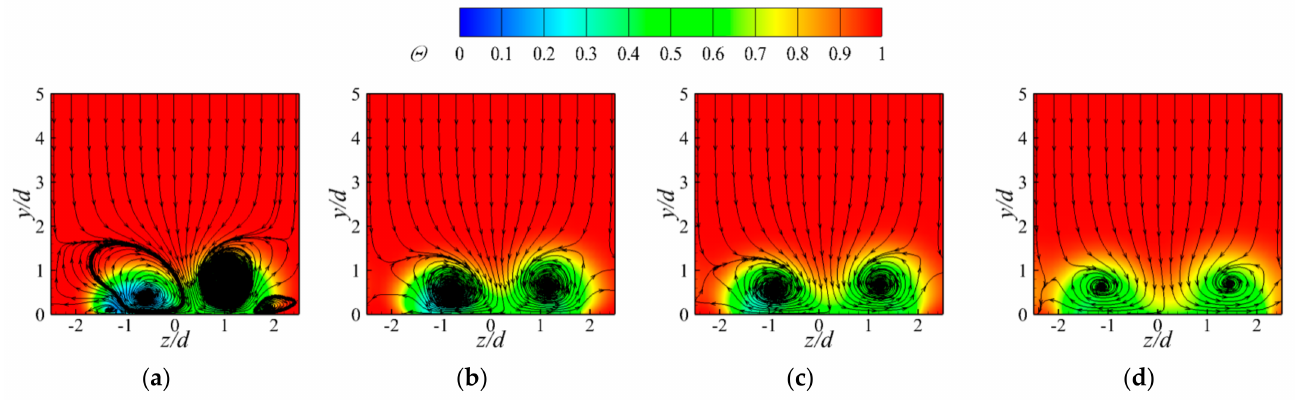
Figure 8. Dimensionless temperature contours and streamlines in downstream normal sections on the pressure side for DJFC under M = 1.5. ( a ) s / d = 3, ( b ) s / d = 6, ( c ) s / d = 9, ( d ) s / d =